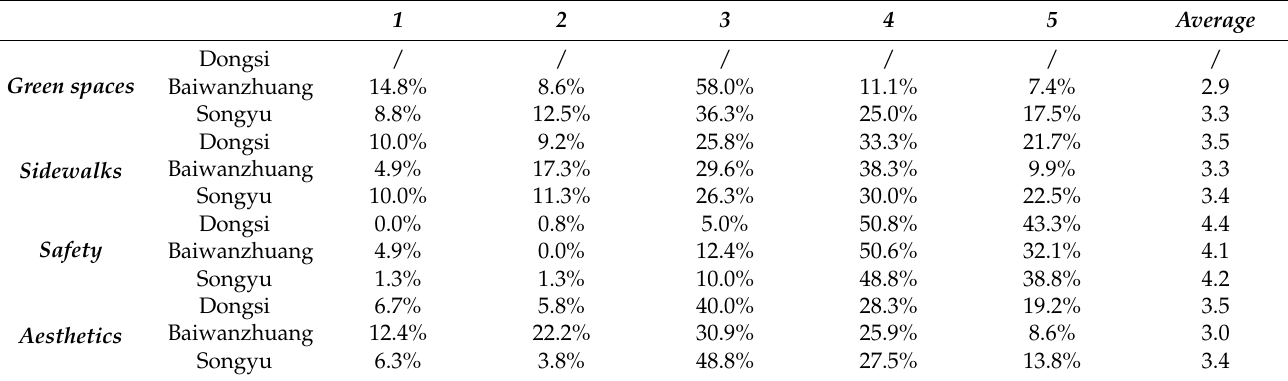
Table 5. Satisfaction of the neighborhoods.